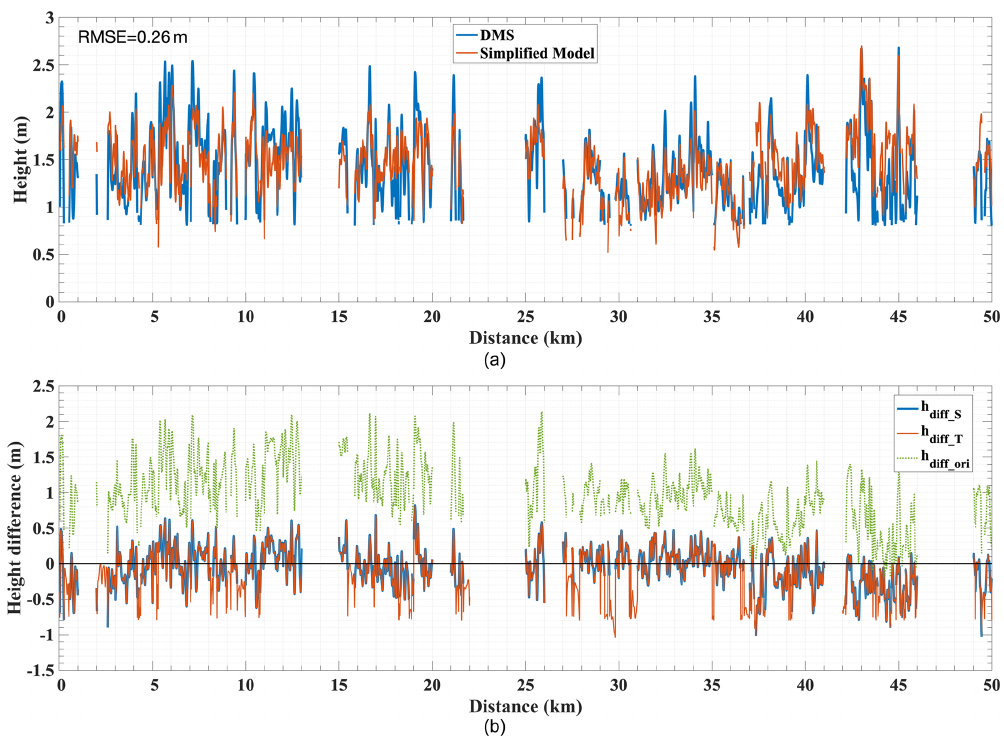
Figure 14. (a) Sea ice height profiles from DMS measurement (blue) and model inversion (red). Each profile represents the height along a 1 × 5000-pixel section at the center of the coregistered segment. (b) Height difference between the DMS measurement and the simplified model-derived height (blue), theoretical model-derived height (red), or original InSAR-derived height (green). The mis-coregistered and h DMS -below-0.8m samples are excluded from the plots. The black line plots 0m as a reference.